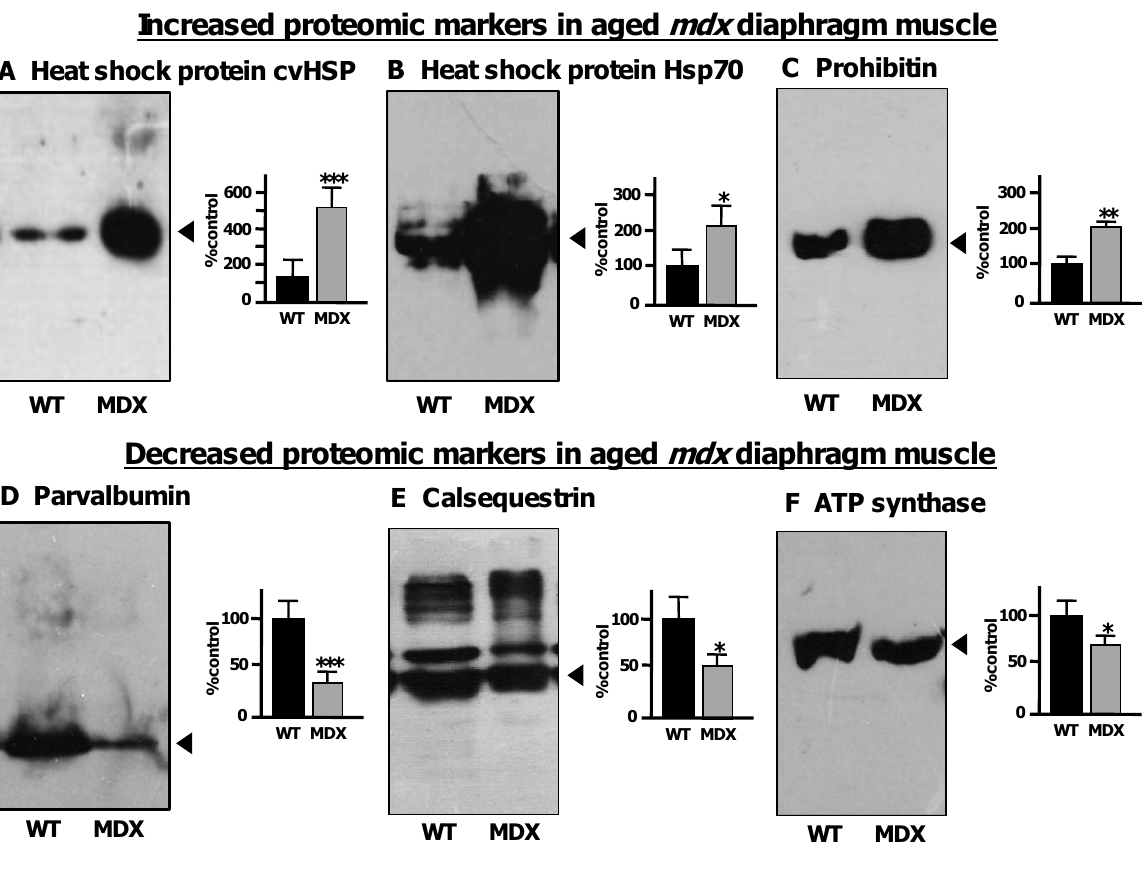
Figure 8. Immunoblot analysis of the aged mdx diaphragm muscle: Shown are representative immunoblots with expanded views of antibody-decorated bands. Lanes 1 and 2 represent preparations from non-dystrophic wild type (WT) versus dystrophic (MDX) diaphragm muscle, respectively. Immuno-decoration was carried out with primary antibodies to heat shock protein cvHsp ( A ), heat shock protein Hsp70 ( B ), prohibitin ( C ), parvalbumin ( D ), the luminal Ca 2+ -binding protein calsequestrin ( E ) and the mitochondrial enzyme ATP synthase ( F ). Besides the individual immunoblots are shown panels, which give a graphical representation of the immuno-decoration levels in normal versus mdx preparations ( (cid:54)(cid:87)(cid:88)(cid:71)(cid:72)(cid:81)(cid:87)(cid:182)(cid:86)(cid:3) t -test, unpaired; n = 4; * p < 0.05; ** p < 0.01, *** p <